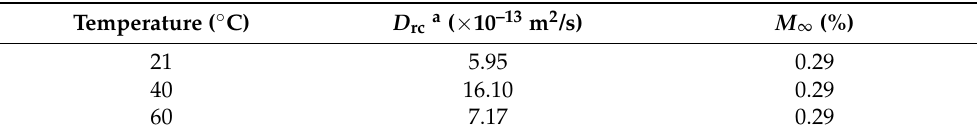
Table 2. The radial diffusivity coefficient of the carbon fiber coat calculated at various